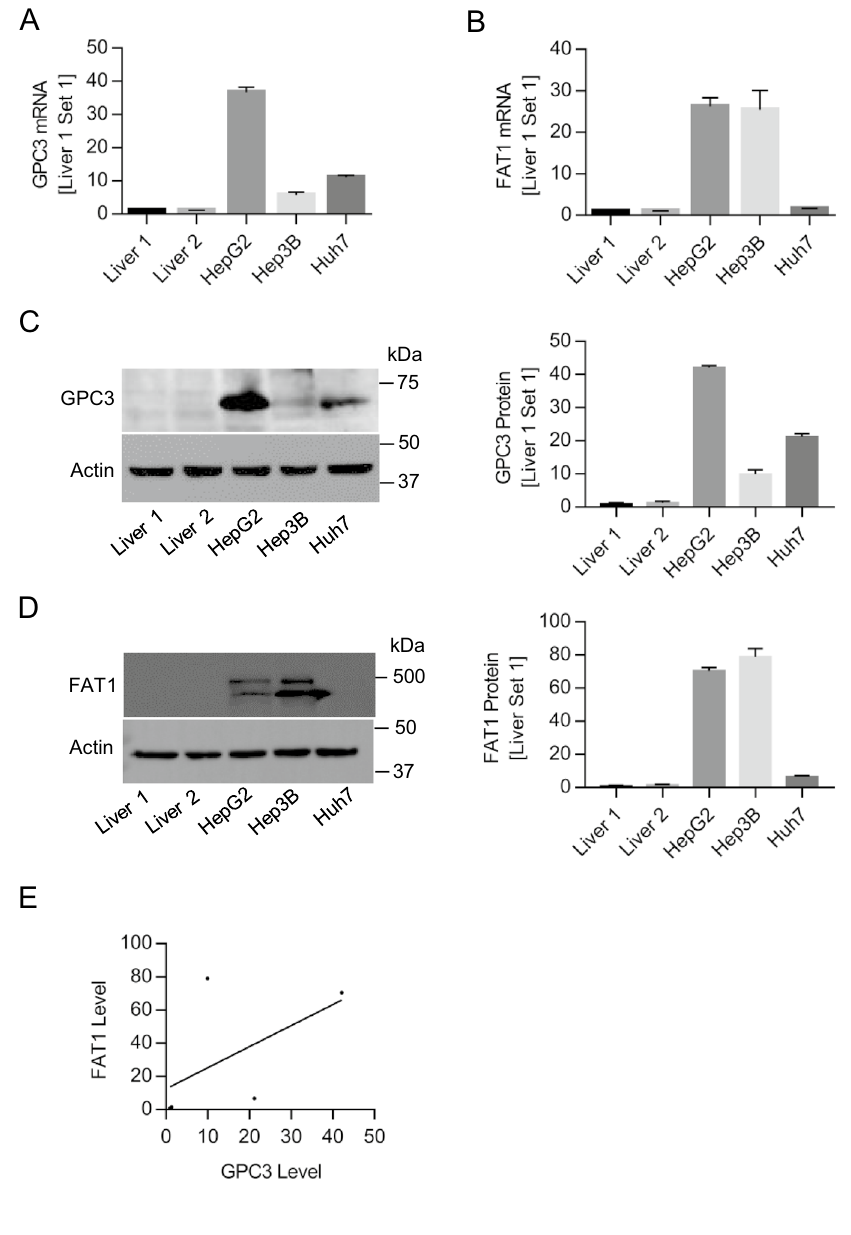
Figure 3. Elevated expression of GPC3 and FAT1 in HCC cell lines. ( A ) The mRNA level of GPC3 in two primary liver tissues and HCC cell lines (HepG2, Hep3B and Huh7) measured by quantitative RT-PCR. ( B ) The mRNA level of FAT1 in the same samples. ( C ) GPC3 protein level of the corresponding tissues and cell lines. Full-length blots/gels were presented in Supplementary Figure S3A. ( D ) FAT1 protein level from the same samples. Full-length blots/gels were presented in Supplementary Figure S3B ( E ) Correlation of GPC3 and FAT1 protein level in three HCC cell lines (HepG2, Hep3B and Huh7). Data represent mean ± SEM (n =